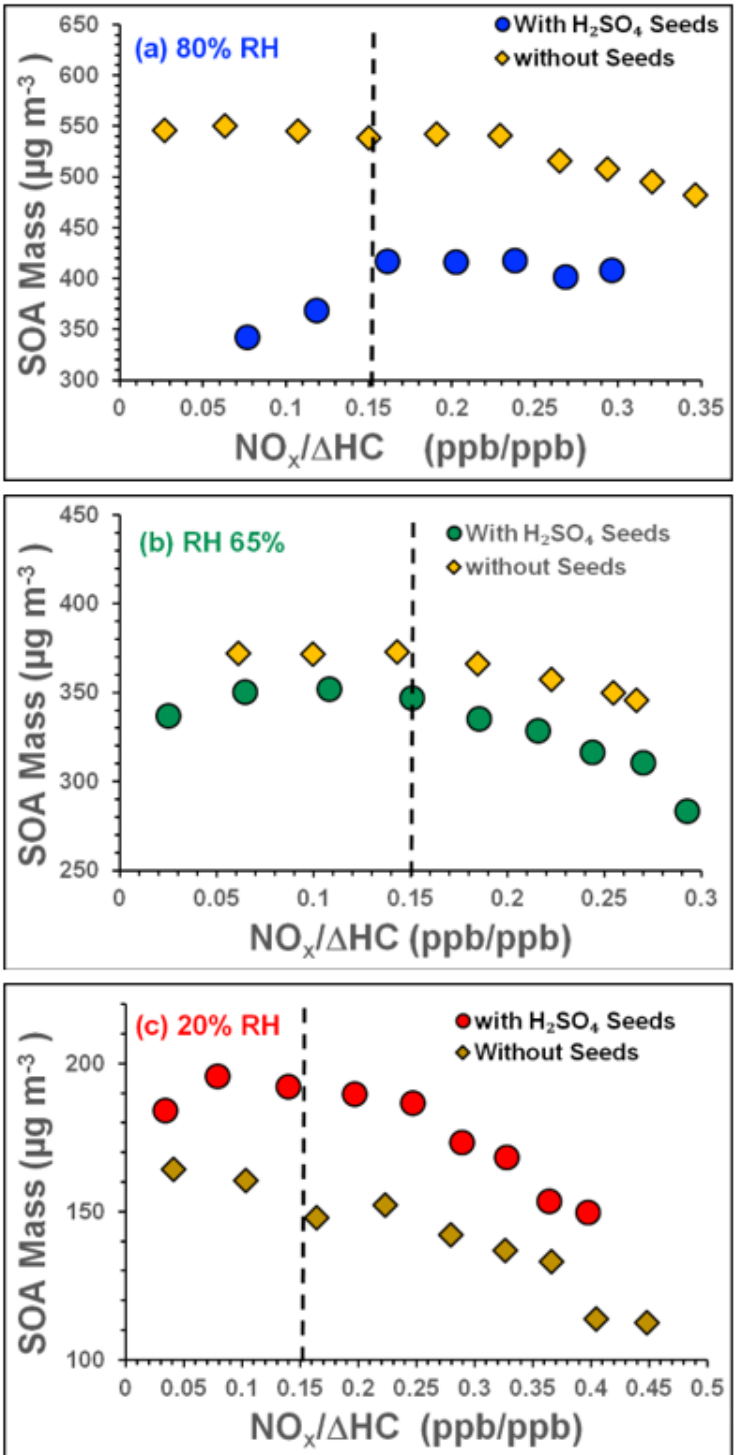
Figure 12. ( a – c ): SOA mass as a function of NO x ]/[ ∆ HC] and the influence of acidity on SOA mass at ( a ) 80% RH, ( b ) 65% RH, and ( c ) 20% RH. The dashed lines are included to guide the eye.